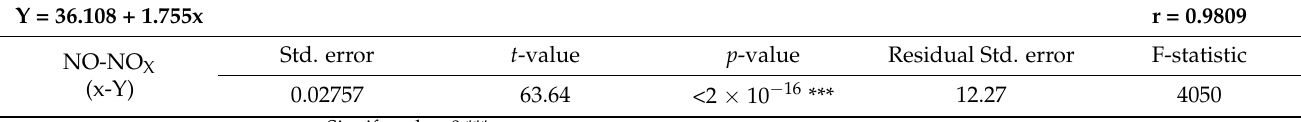
Table 5. Summary statistics from linear regression model for NO and NO X .